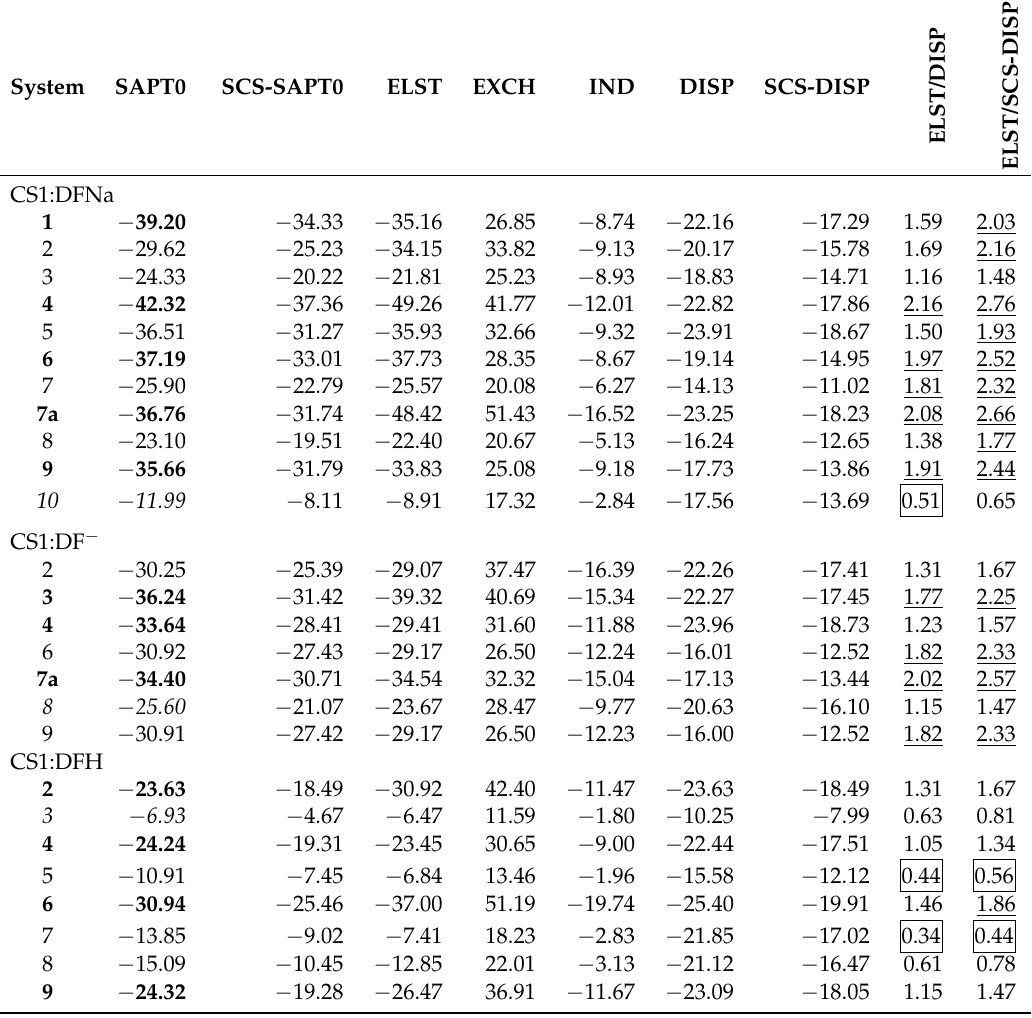
Table 2. SAPT0/aug-cc-pVDZ interaction energy components for interaction of single chitosan unit CS1 with DFNa, DF − and DFH (boldfaced most attractive SAPT0 interaction, boxes for ELST/DISP ratio smaller than 0.59, denoting dispersion-dominated systems and underlined energies for ELST/DISP ratio exceeding 1.7, denoting electrostatic-dominated systems according to Ref. [60]; for the system structures see Figures 1, 3 and 4 and Supplementary